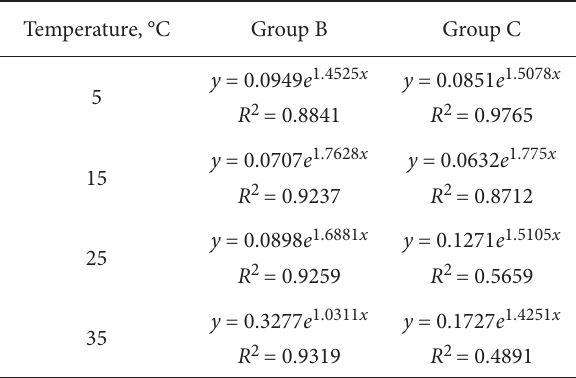
Table 5. Correlations between compressive strength and ultrasonic velocity Temperature,